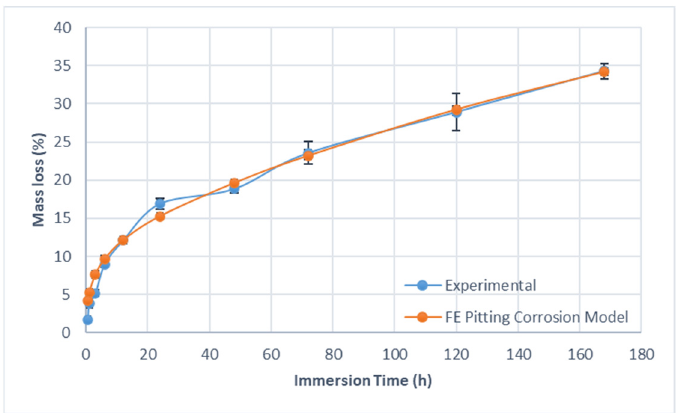
Figure 9. Mass loss versus corrosion time from corrosion experiment 1. The FE pitting corrosion model results are also shown for comparison purposes. Error bars represent a single standard deviation from the mean (n = 3). Table 1. Average mechanical properties for both as-drawn and annealed wire specimens (n = 3).